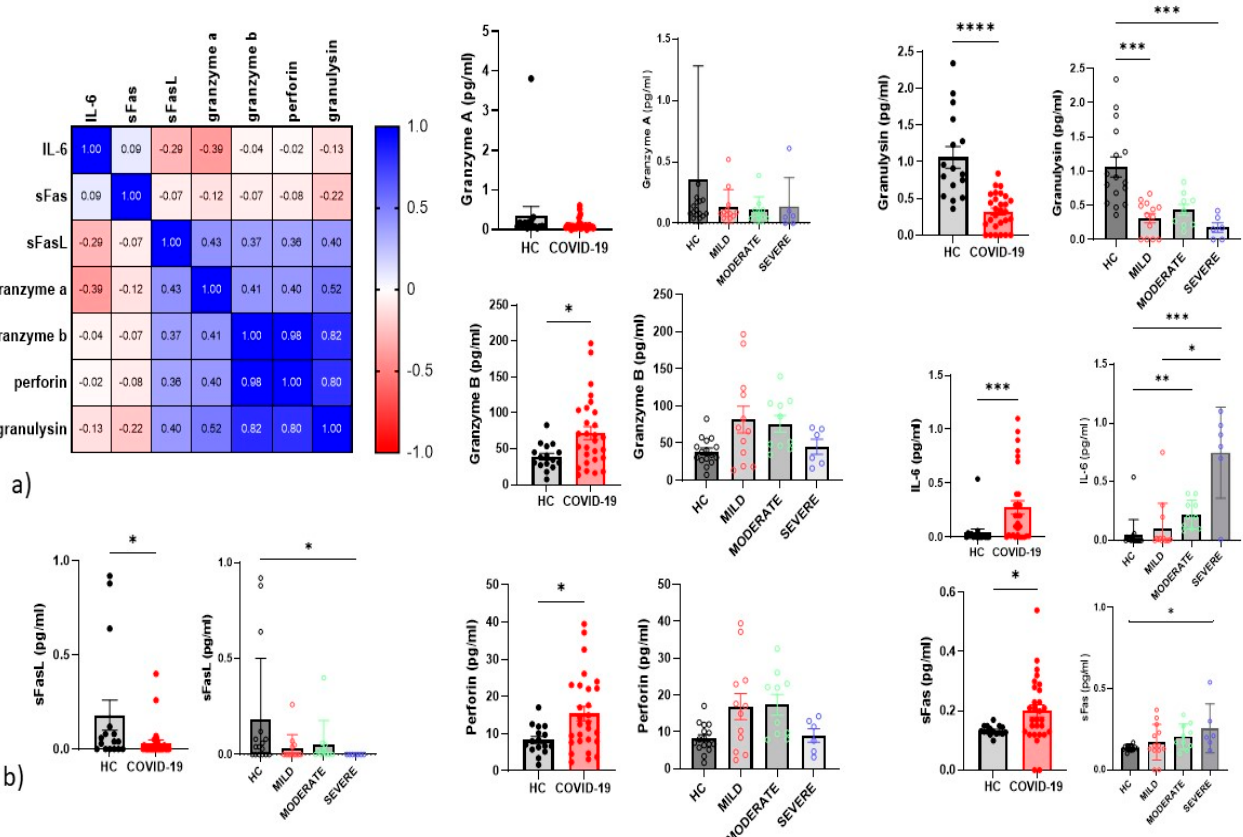
Figure 6. ( a ) Correlation Matrix of cytokines ( b ) Serum cytokine levels from the healthy controls (n = 17). and all COVID-19 patients (n = 35) and among mild cases (n = 15). moderate cases (n = 12) and severe cases (n = 8). The level of significance is indicated as follows: ns. notsignificant; * p < 0.05. ** p < 0.01, *** p < 0.001, and **** p < 0.0001.